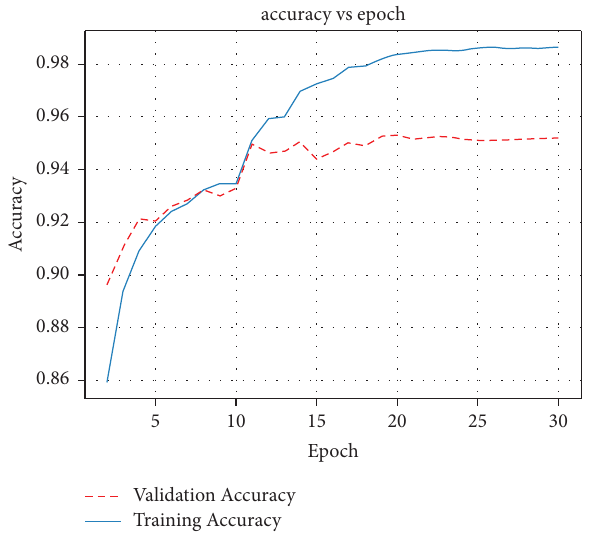
Figure 8: Observed accuracy for case